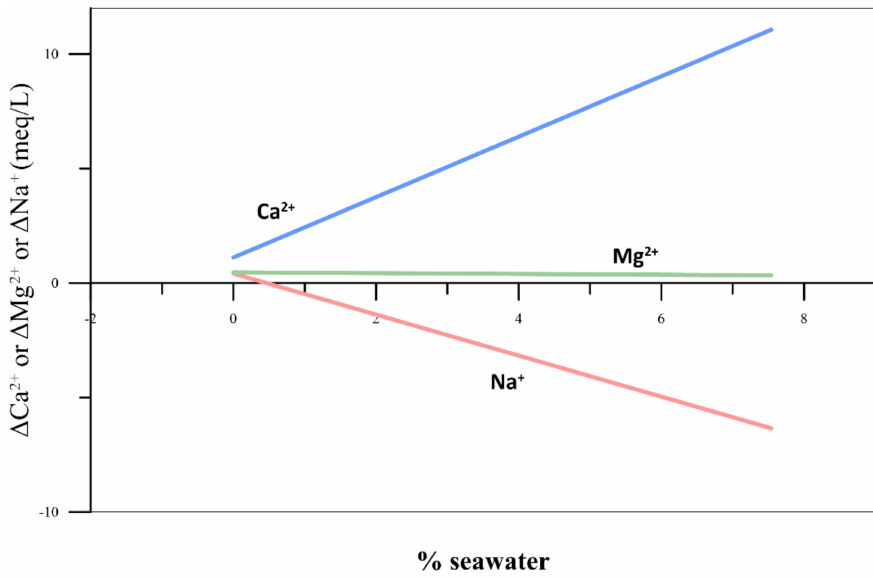
Figure 3. Plots of ∆ Ca 2+ , ∆ Mg 2+ , and ∆ Na + vs. the percentage of seawater equal to the mixing ratio using conservative ions.